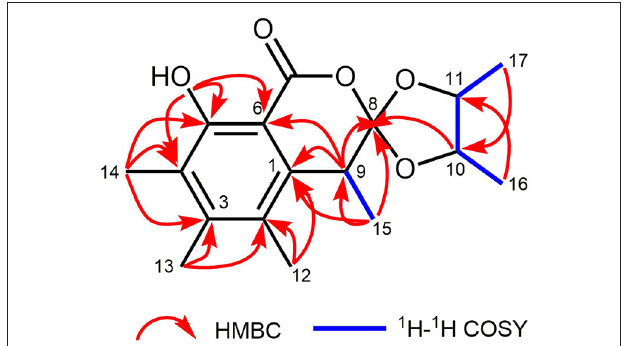
FIGURE 2 | Key 1H − 1H COSY and HMBC correlations of 1